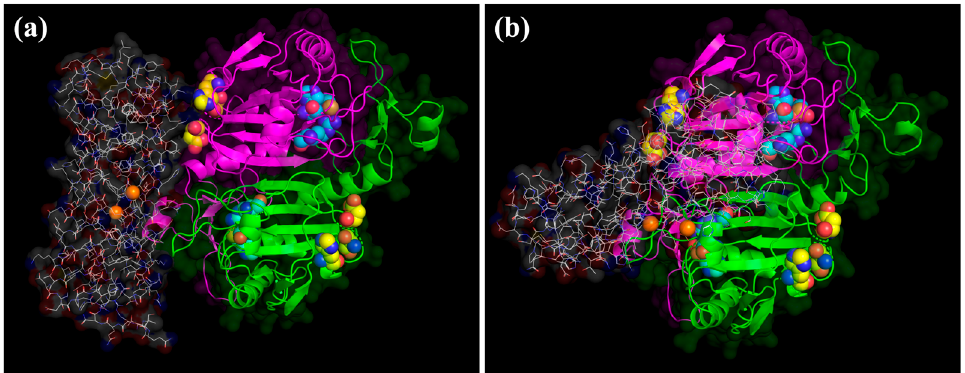
Figure 5. Most stable theoretical complexes of FTH1 with ( a ) PRDX6_r and ( b ) PRDX6_s. Ferritin protein is depicted as wireframe CPK colored, and PRDX6 chains are shown as green and magenta cartoon. PRDX6 residues at peroxidase and phospholipase sites are reported as space-filling yellow carbon or cyan carbon colored, respectively. Ferritin-bound Fe 2+ ions are shown as orange space-filling.